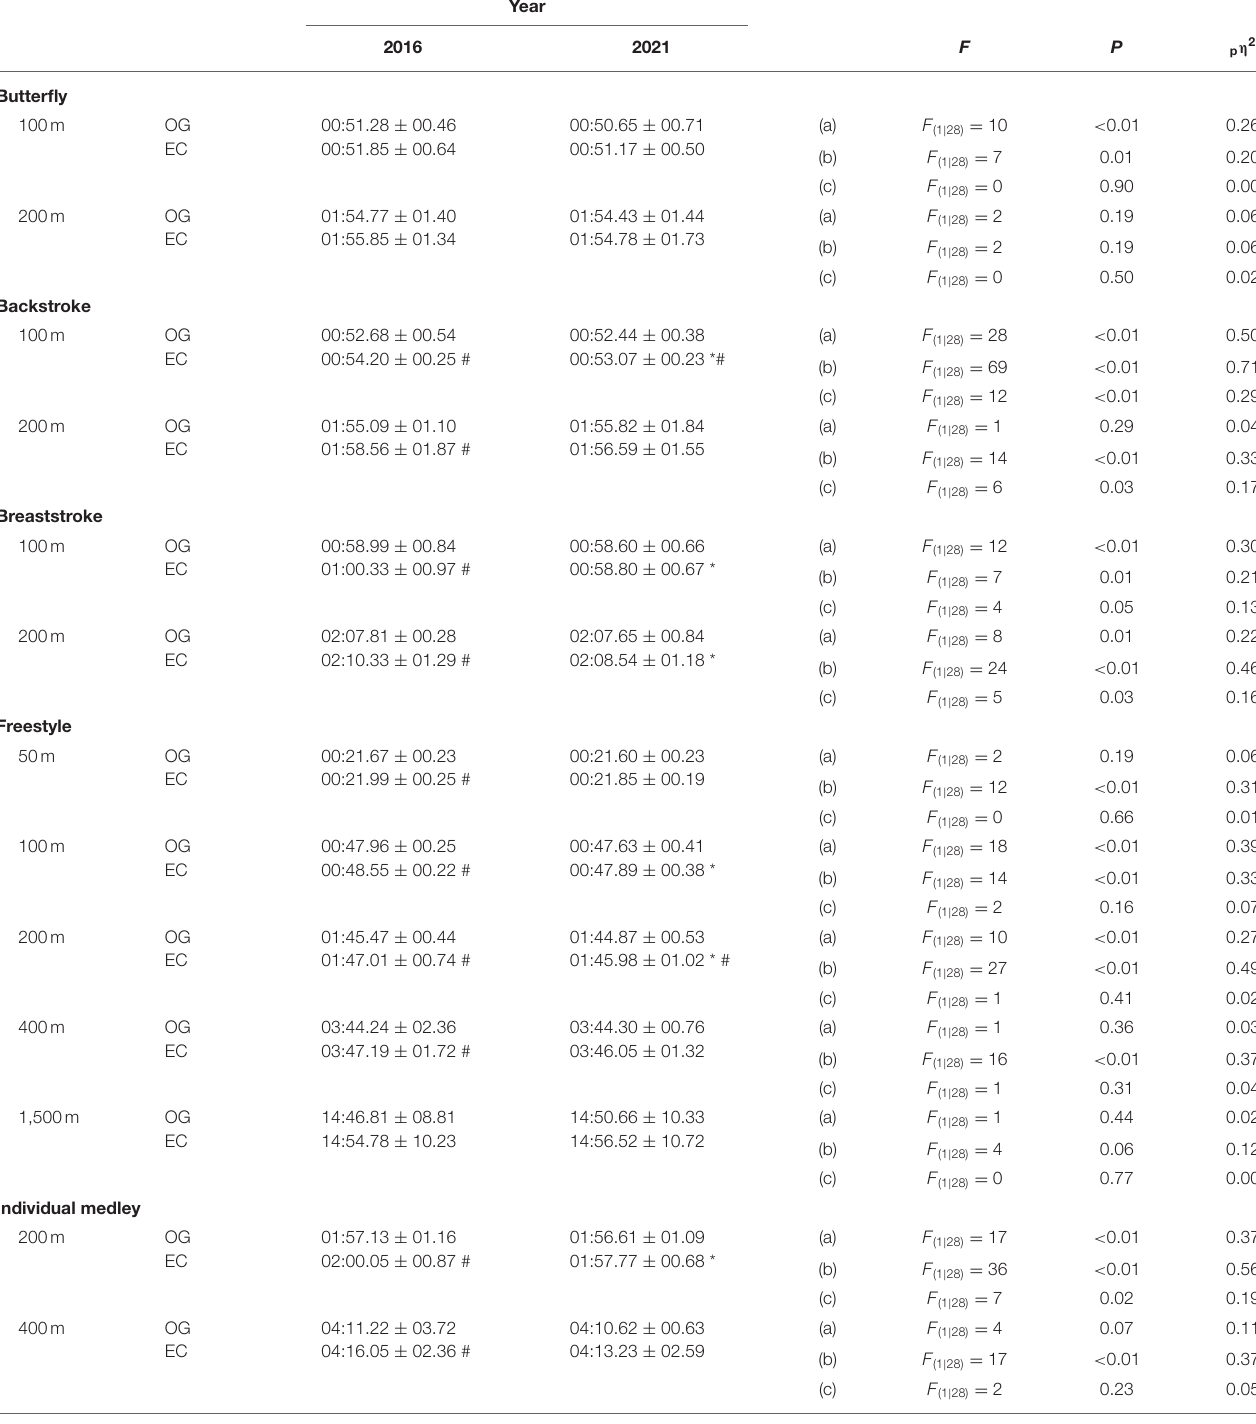
TABLE 2 | Development of race times in male finalists at the Olympic Games (OG) and European championships (EC) across the 5-year Olympic